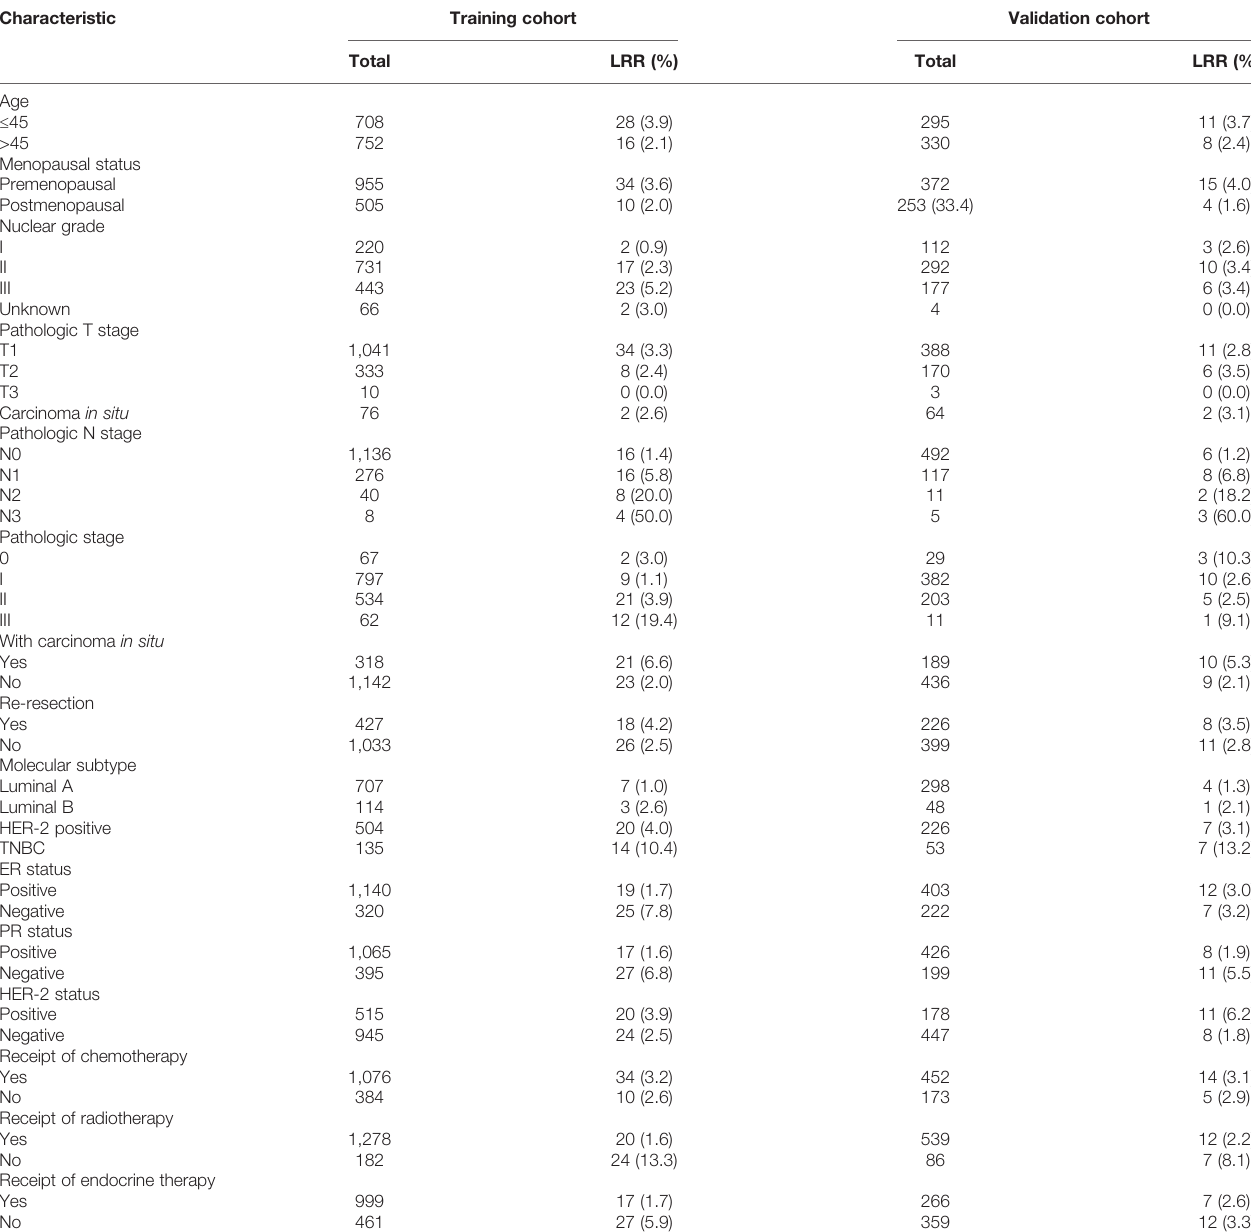
TABLE 1 | The basic information, tumor characteristics, and treatment methods of breast cancer patients receiving BCT.